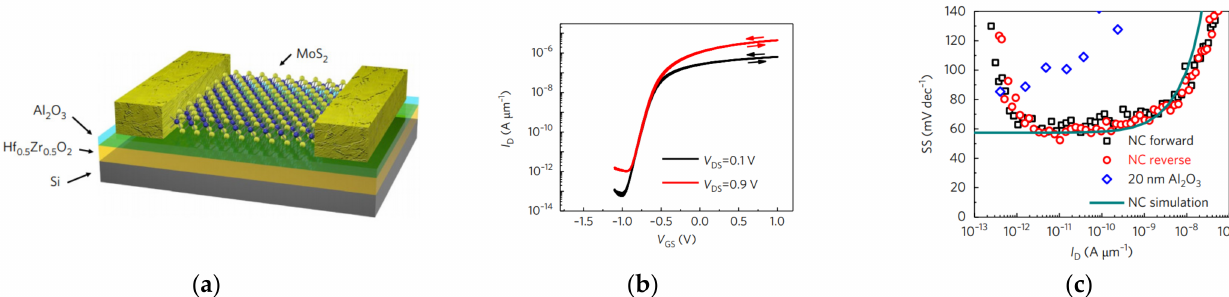
Figure 10. HZO MoS 2 NC-FET: ( a ) Schematic view of a MoS 2 NC-FET; ( b ) I DS -V GS characteristics of MoS 2 NC-FET, and ( c ) the measured and simulated SS of the MoS 2 NC-FET in forward and reverse sweeps. Reproduced with permission [91]. Copyright 2017, Springer Nature